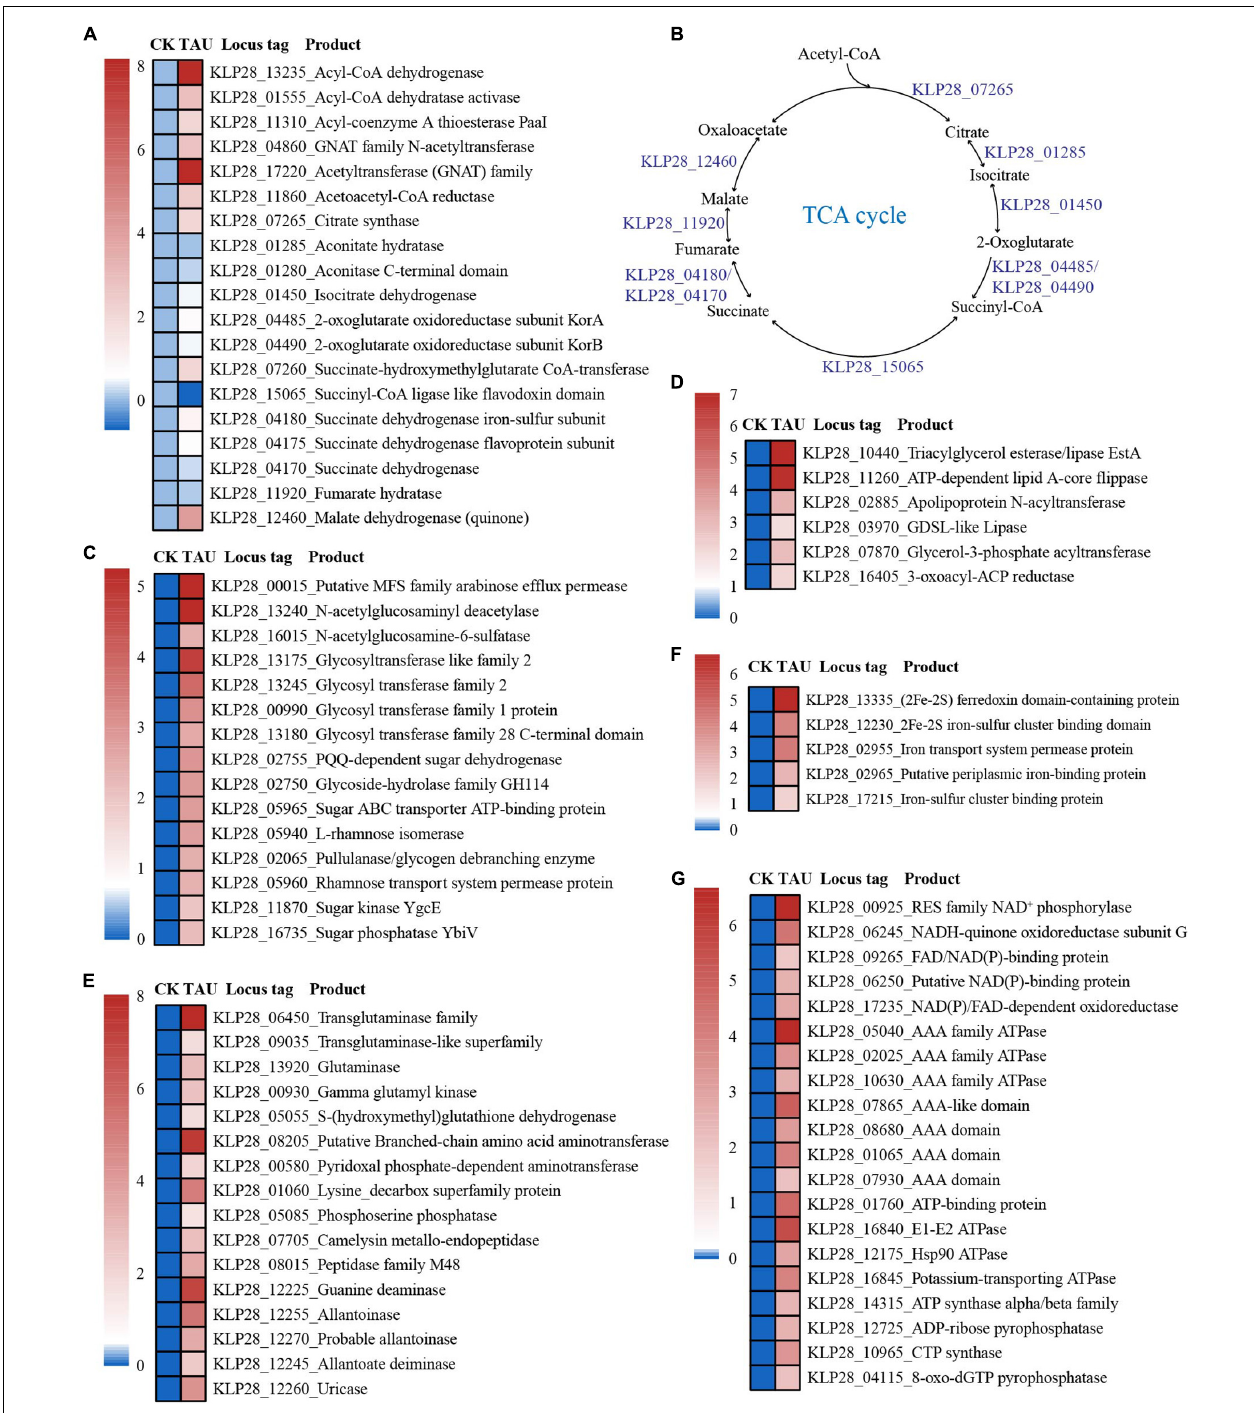
FIGURE 3 | Transcriptomic analysis of essential metabolic pathways for energy production in strain TYQ2 that cultured in the medium supplemented with taurine. (A) A heat map based on transcriptomics showing the up-regulated genes involved in acetyl-CoA synthesis and metabolism and the tricarboxylic acid cycle. (B) The diagram of the tricarboxylic acid cycle of strain TYQ2. The gene numbers are the same to those shown in panel (A) . (C) A heat map based on transcriptomics showing all the up-regulated genes involved in sugar transport and metabolism. (D) A heat map based on transcriptomics showing all up-regulated genes related to lipid metabolism. (E) Transcriptomics-based heat map showing all up-regulated genes related to amino acid and nucleotide metabolism. (F) A heat map based on transcriptomics showing all up-regulated genes encoding iron-sulfur proteins. (G) A heat map based on transcriptomics showing the up-regulation of all genes related to NAD(P)/FAD/NADH oxidoreductase and